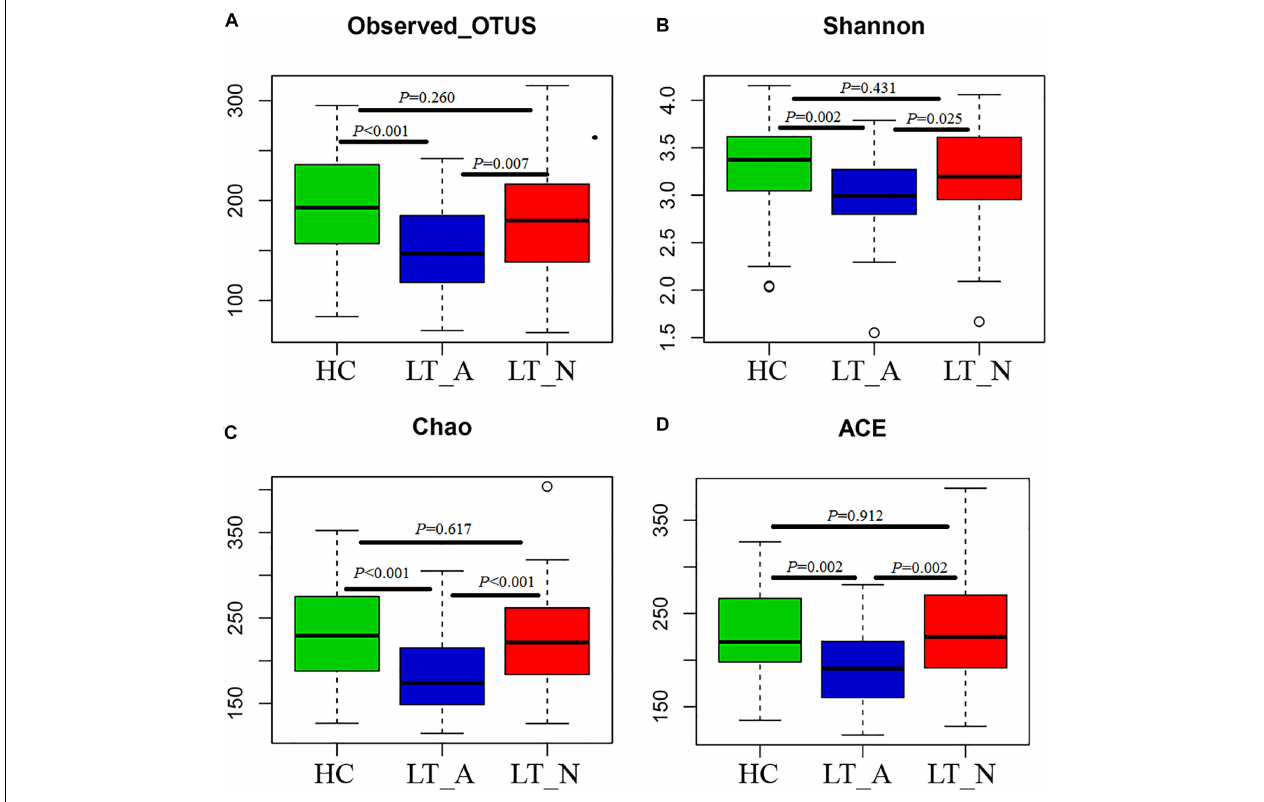
FIGURE 1 | Phylogenetic diversity of fecal microbiomes between liver transplant recipients and healthy subjects. (A–D) Box plots depicting microbiome diversity differences according to the number of OTUs detected, the Shannon index, the Chao 1 index, and the ACE index, respectively. “+” represents the median value, while the upper and lower ranges of the box represent the 75 and 25% quartiles, respectively. LT_A, fecal microbiomes of the liver recipients with abnormal liver function; LT_N, fecal microbiomes of the liver recipients with normal liver function; HC, fecal microbiomes of the healthy control group; OTU, operational taxonomic unit.